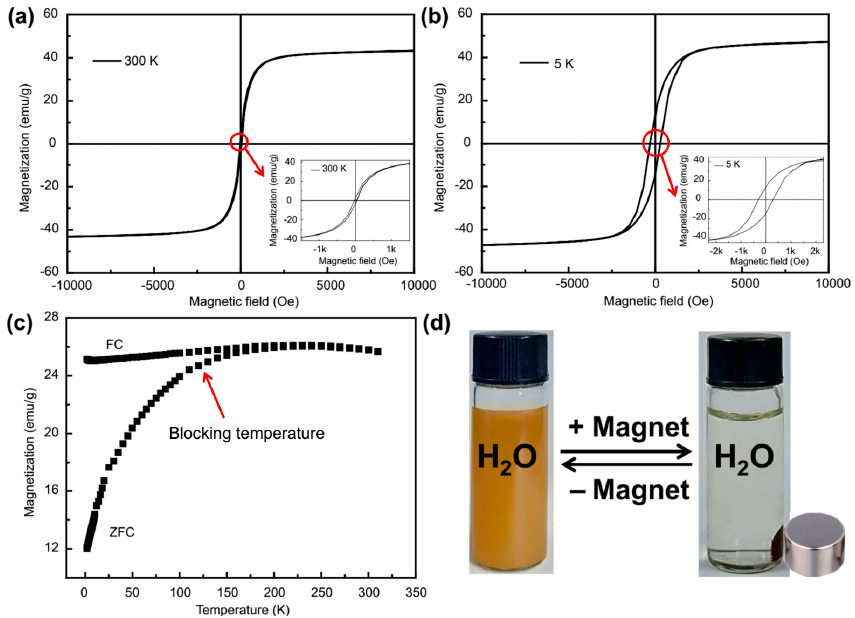
Figure 5. Hysteresis curves at ( a ) 300 K and ( b ) 5 K, ( c ) ZFC and FC curves and ( d ) the segregation and diffusion process of Fe 3 O 4 @ 1 .